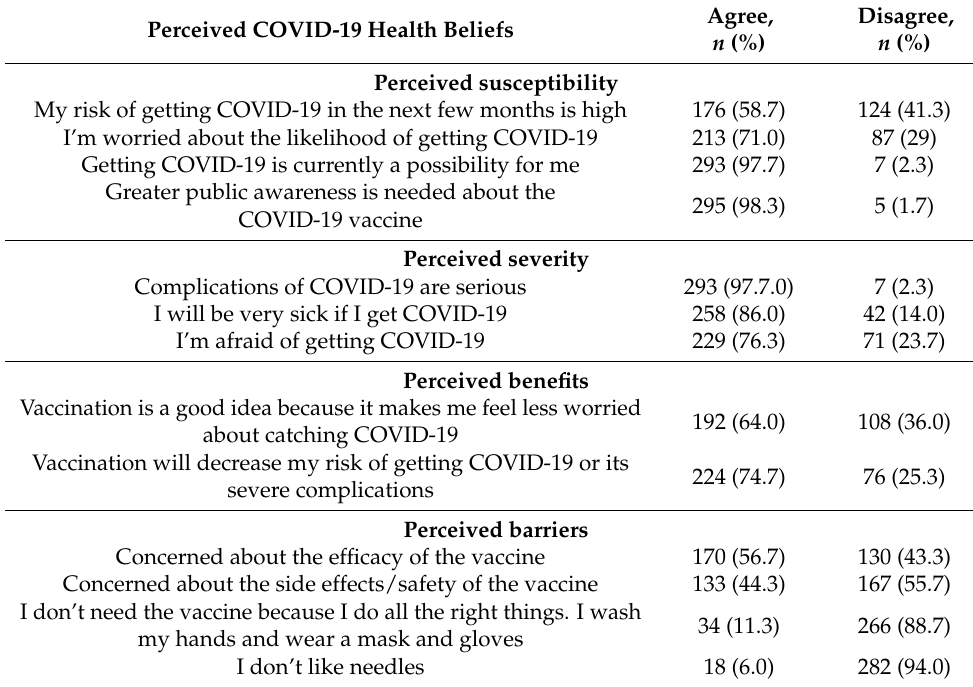
Table 2. COVID-19-related health beliefs of eye healthcare workers in Uganda ( n = 300). Perceived COVID-19 Health Beliefs